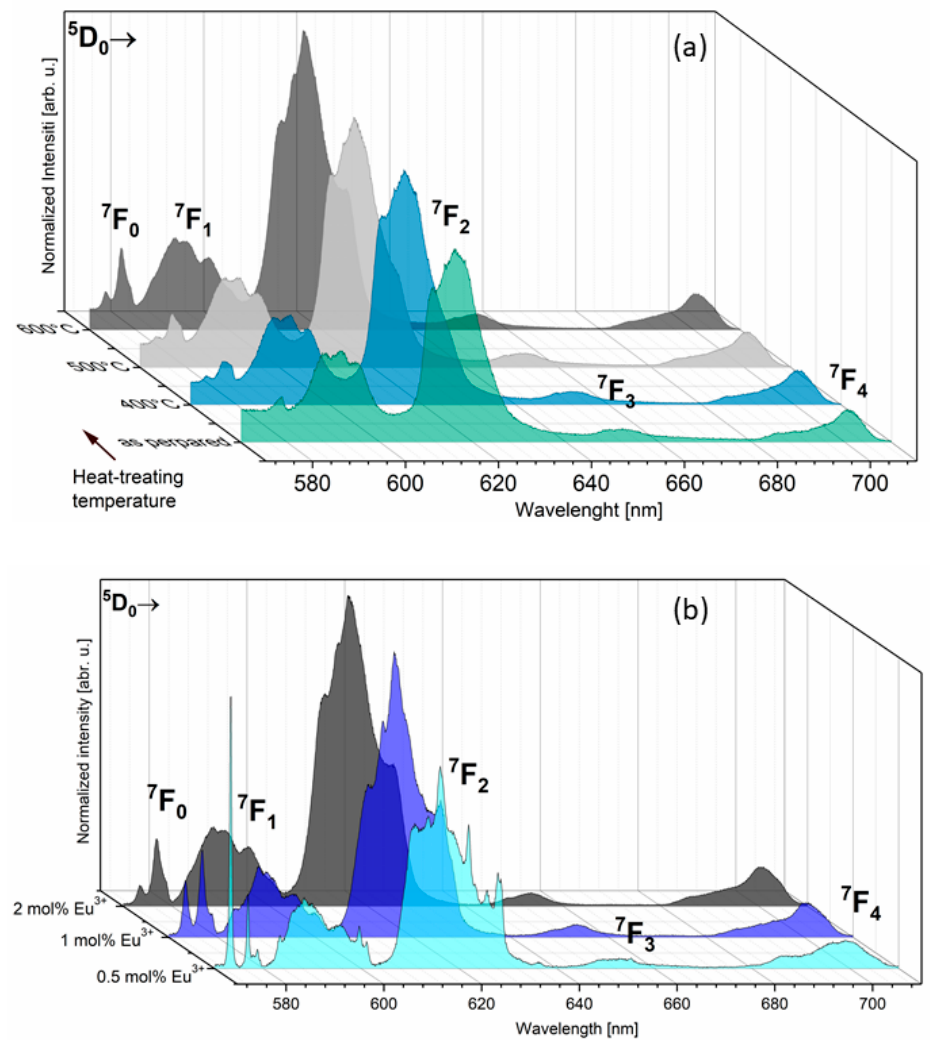
Figure 4. Emission spectra of Ca 9.6 Sr 0.2 Eu 0.2 (PO 4 ) 2 (SiO 4 ) 4 (OH) 2 as a function of sintering temperature ( a ) and Ca 9.8-x Sr 0.2 Eu x (PO 4 ) 2 (SiO 4 ) 4 (OH) 2 , where x = 0.5, 1.0, 2.0 mol%, sintered at 600 °C ( b ).